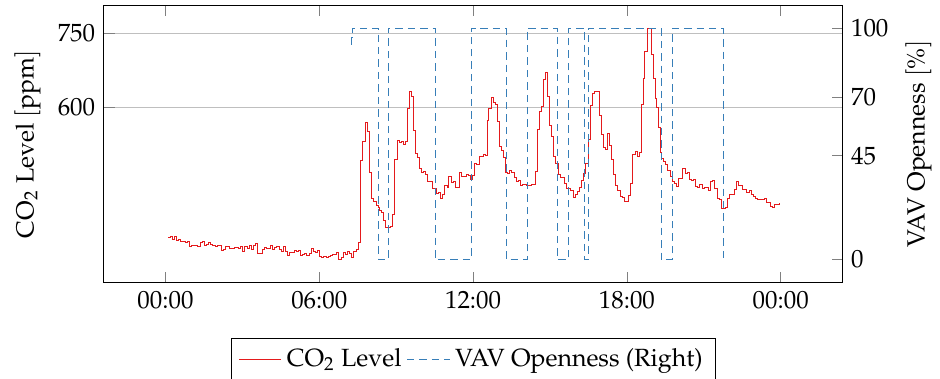
Figure 12. Anomalous behaviour of room ventilation. CO 2 level is below the threshold during the day, but the VAV unit is often completely open. Room temperature is steadily below 24 ◦ C during the day, therefore, it cannot cause ventilation to